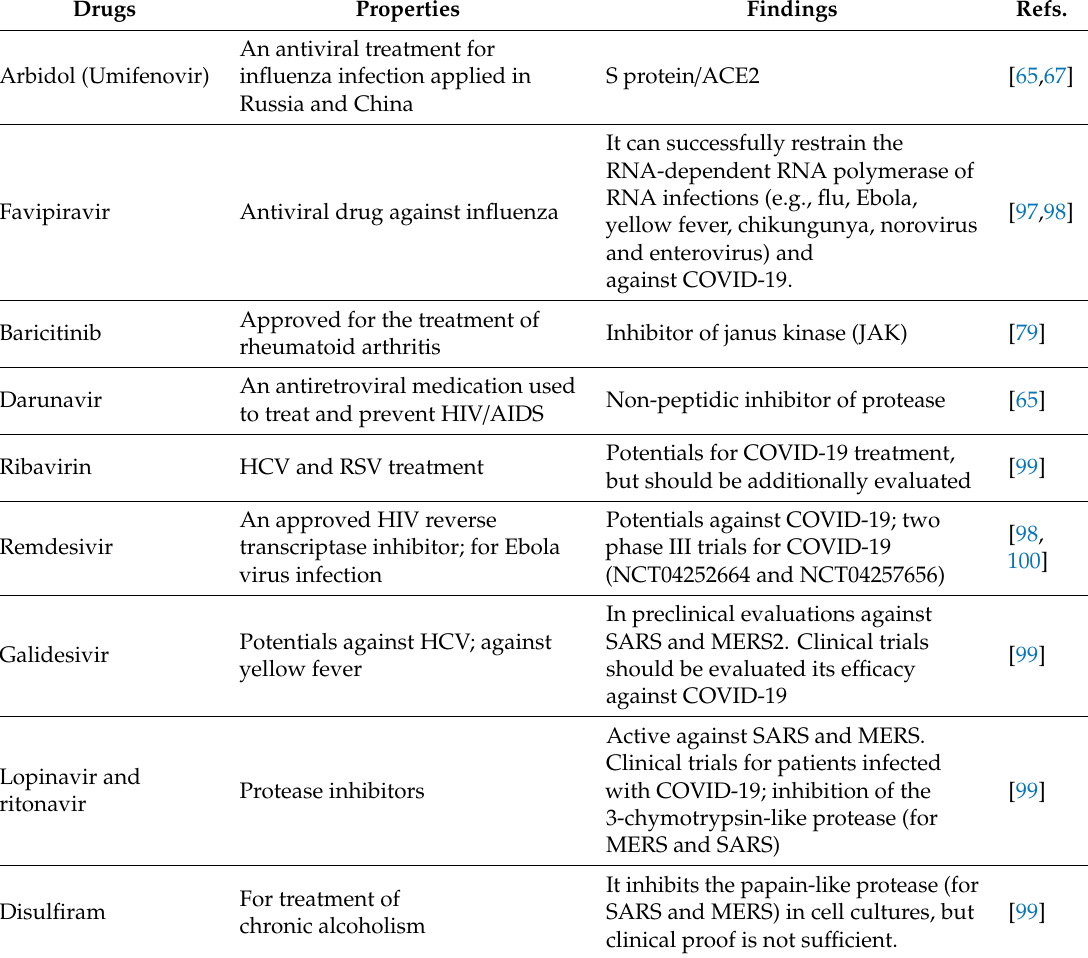
Table 1. Some prominent drugs in clinical evaluations / development stages for COVID-19. Drugs Properties Findings